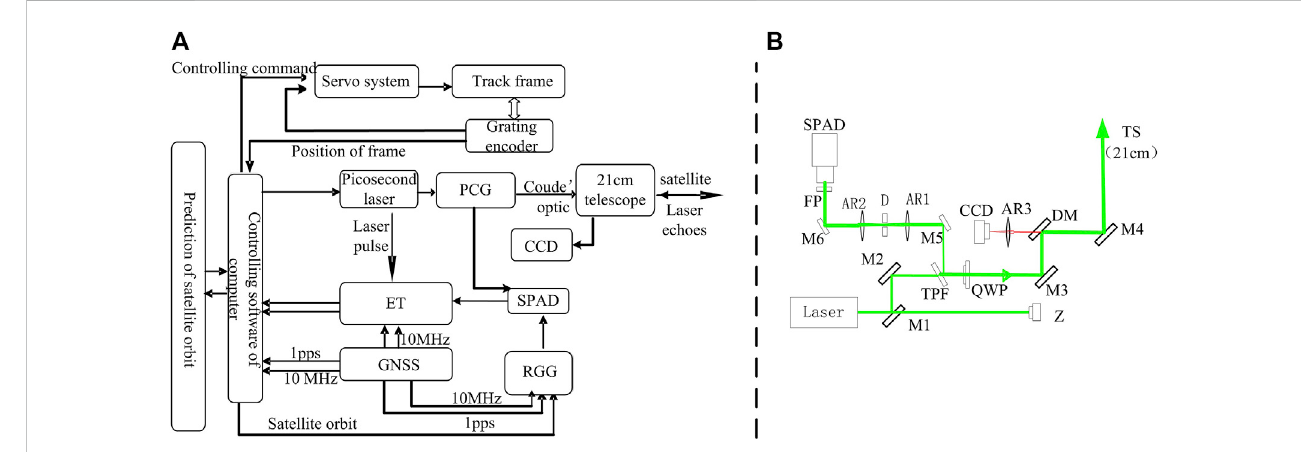
FIGURE 2 Structure (A) and optical path diagram (B) of the polarized coaxial SLR